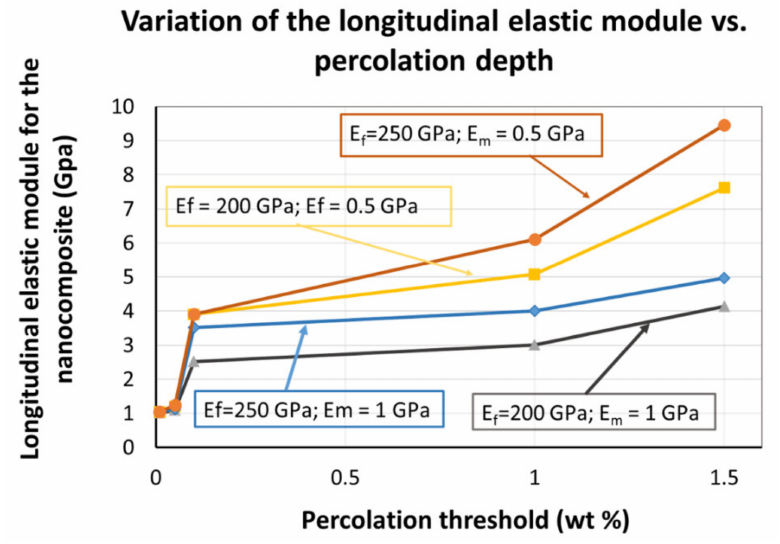
Figure 10. The nanocomposite’s longitudinal elastic module (EL) variation, as a function of electrical percolation threshold (experimentally determined in this